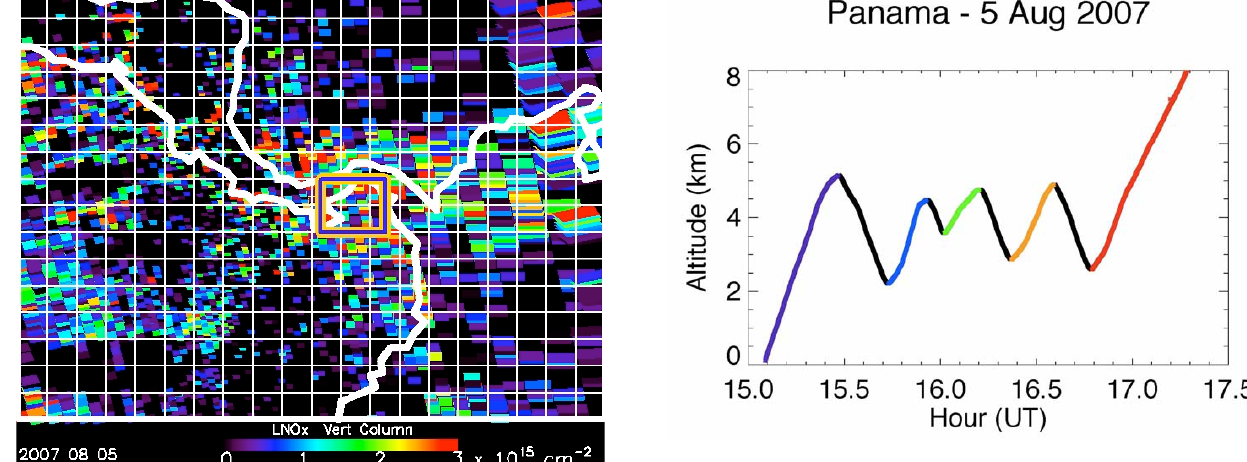
Figure 3. Gridded (1 0 (cid:1) 1 0 ) OMI lightning NO x in the Panama area on 5 August 2007. (a) 4 Fig. 3. Gridded (1 ◦ × 1 ◦ ) OMI lightning NO x in the Panama area on 5 August 2007. The larger region was used for the first estimate, Shows the larger region used for the first estimate, while (b) shows the smaller region in the 5 Gulf of Panama used for the second estimate (see text). 6 while the smaller boxed region in the Gulf of Panama was used for the second estimate (see text).